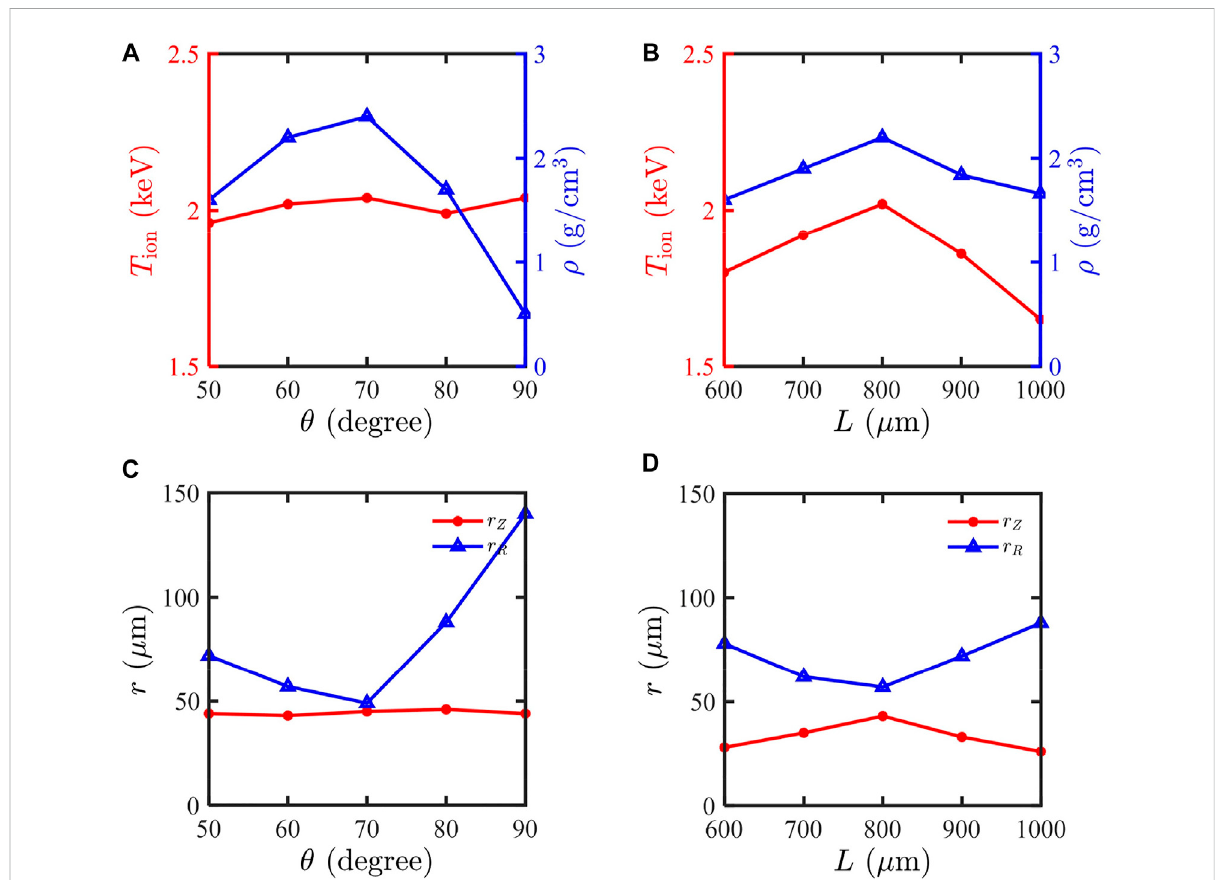
FIGURE 7 Maximum density and ion temperature evolve as the opening angle (A) and the distance of cone tips (B) . (C,D) correspond to the hotspot-like plasma along the R-axis and Z -axis under the same